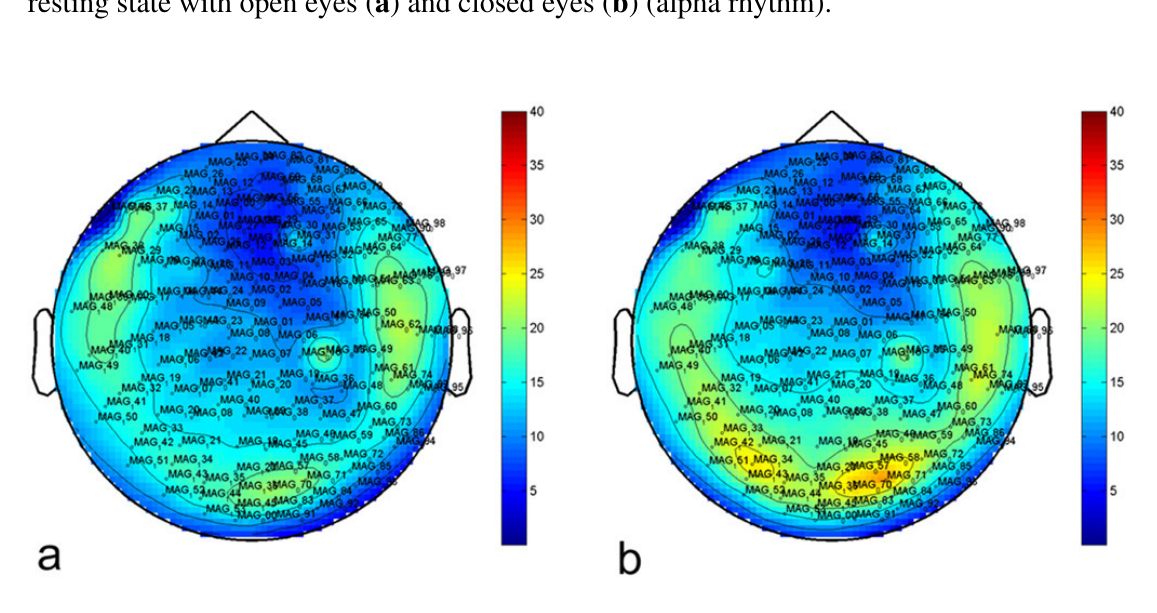
Figure 9. Topographic distribution over the head of the power-spectrum in the range 10–12 Hz after the application of the noise-reduction algorithm for a subject recorded in resting state with open eyes ( a ) and closed eyes ( b ) (alpha